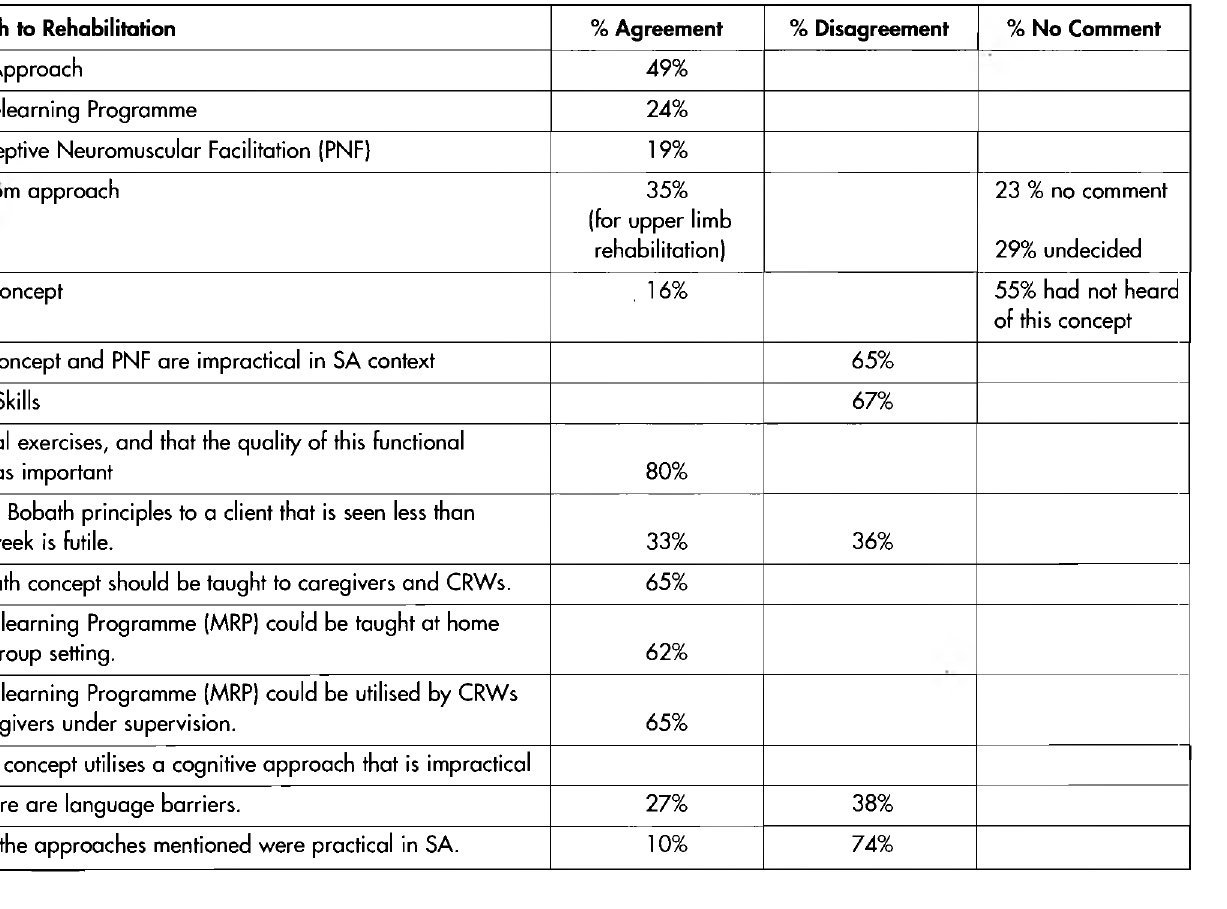
TABLE 3. Consensus on techniques advocated as the best practice on which stroke rehabilitation in South Africa can be based. Approach to